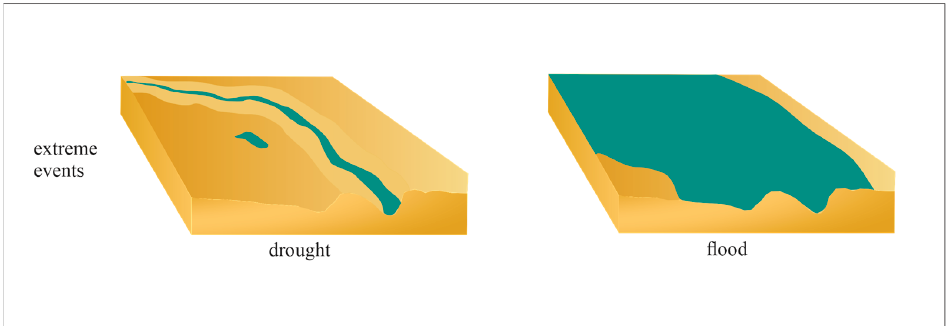
Figure 1. Floodplain lake during extreme hydrological events (drought and